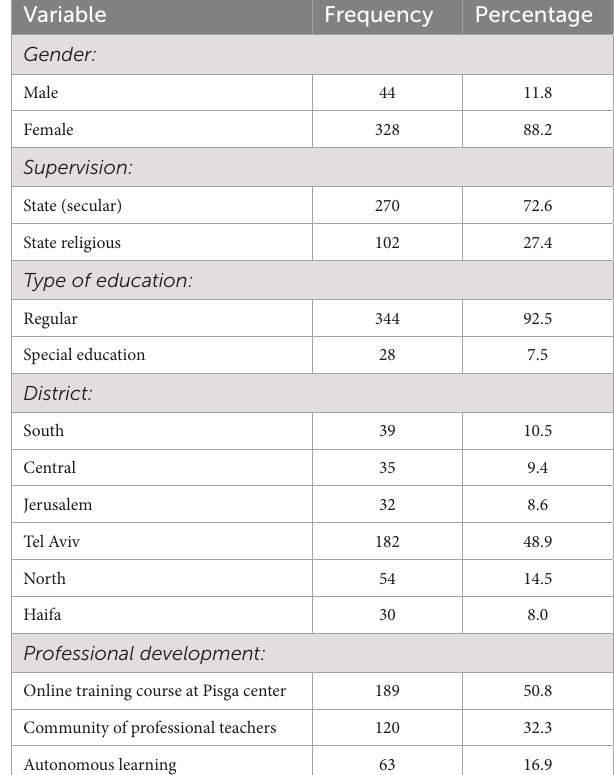
TABLE 2 Breakdown of the